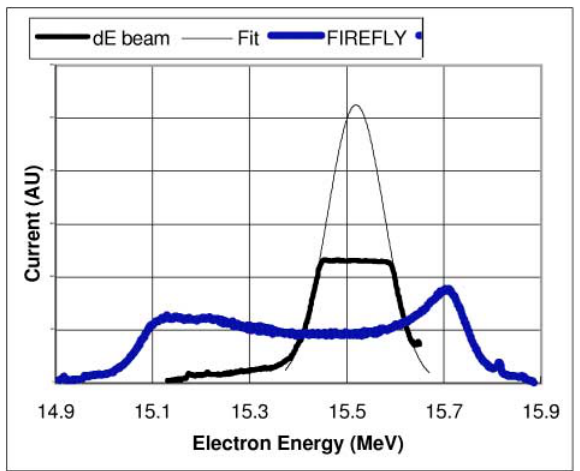
FIG. 8. (Color) Typical measured beam energy spreads with and without FIREFLY lasing. The unperturbed beam had an energy spread of about 130 keV FWHM as shown by the equal-area fit. (The spectrometer camera was saturated for this measurement.) With FIREFLY lasing at this particular desynchronism, the induced energy spread was 4.4% and the FEL efficiency (mean energy loss of the beam) was